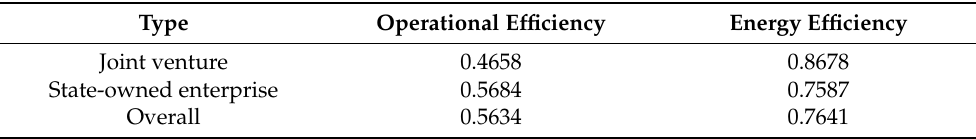
Table 3. The average efficiency of the URT systems in case